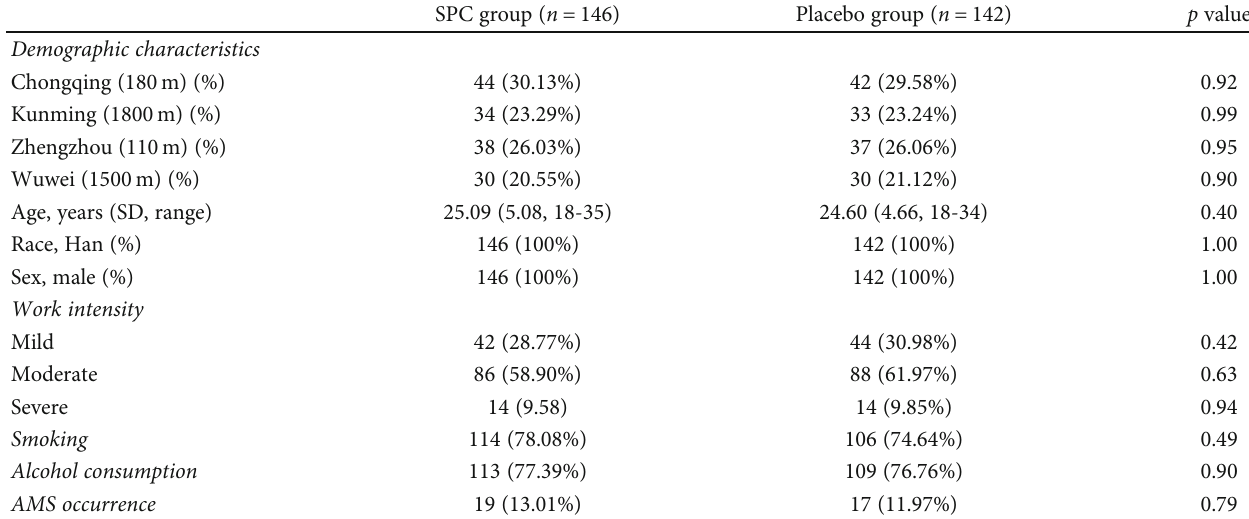
Table 1: Baseline characteristics of subjects at randomization according to the study group.